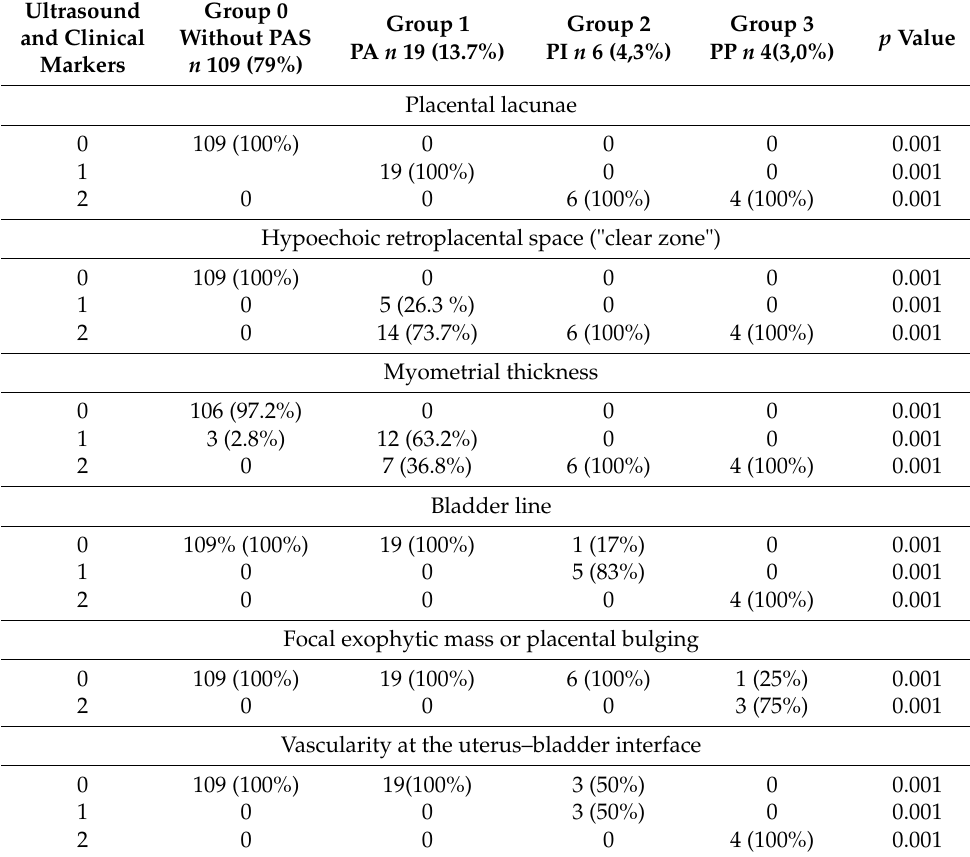
Table 3. Parameters predictive of